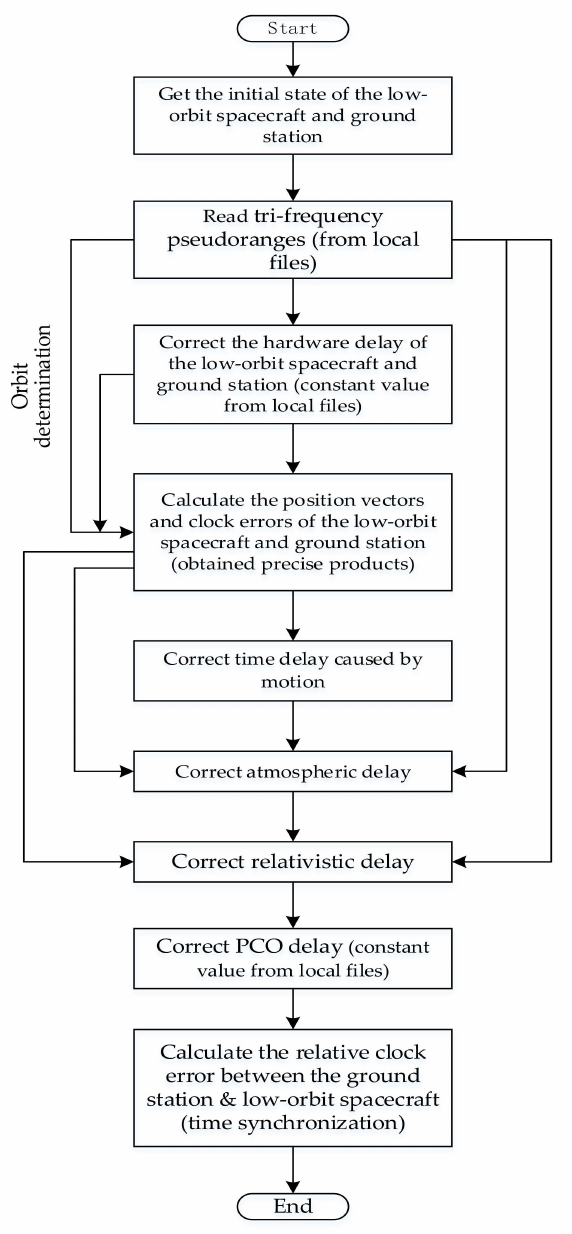
Figure 2. The detailed process of the two-way time synchronization